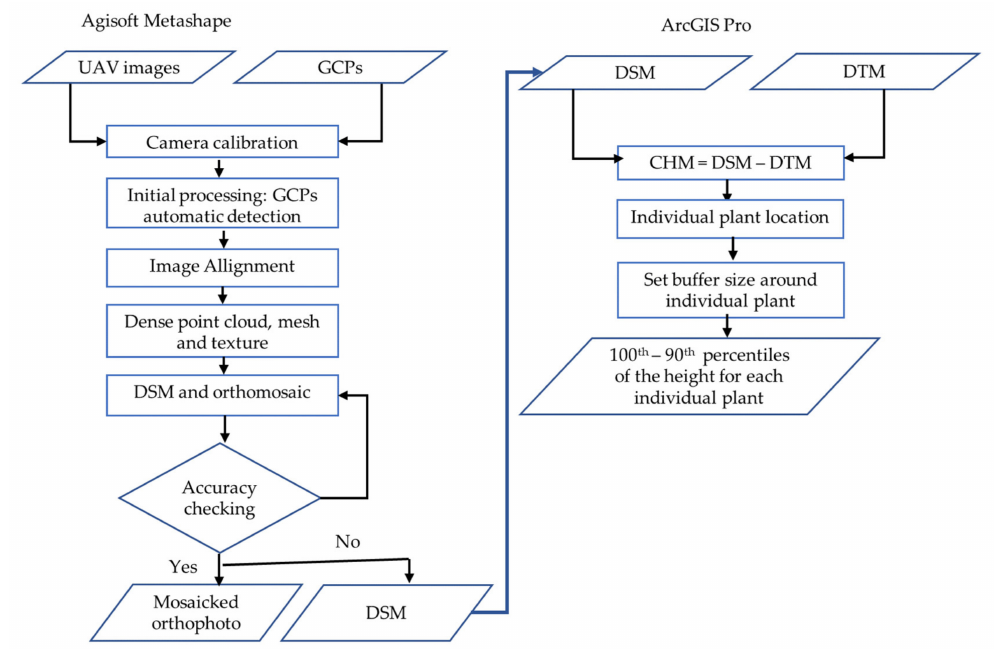
Figure 3. Flowchart depicting the general overview of the methodology for calculating the canopy height model (CHM) and the height of individual plants that involved processing in Agisoft Metashape and ArcGIS Pro